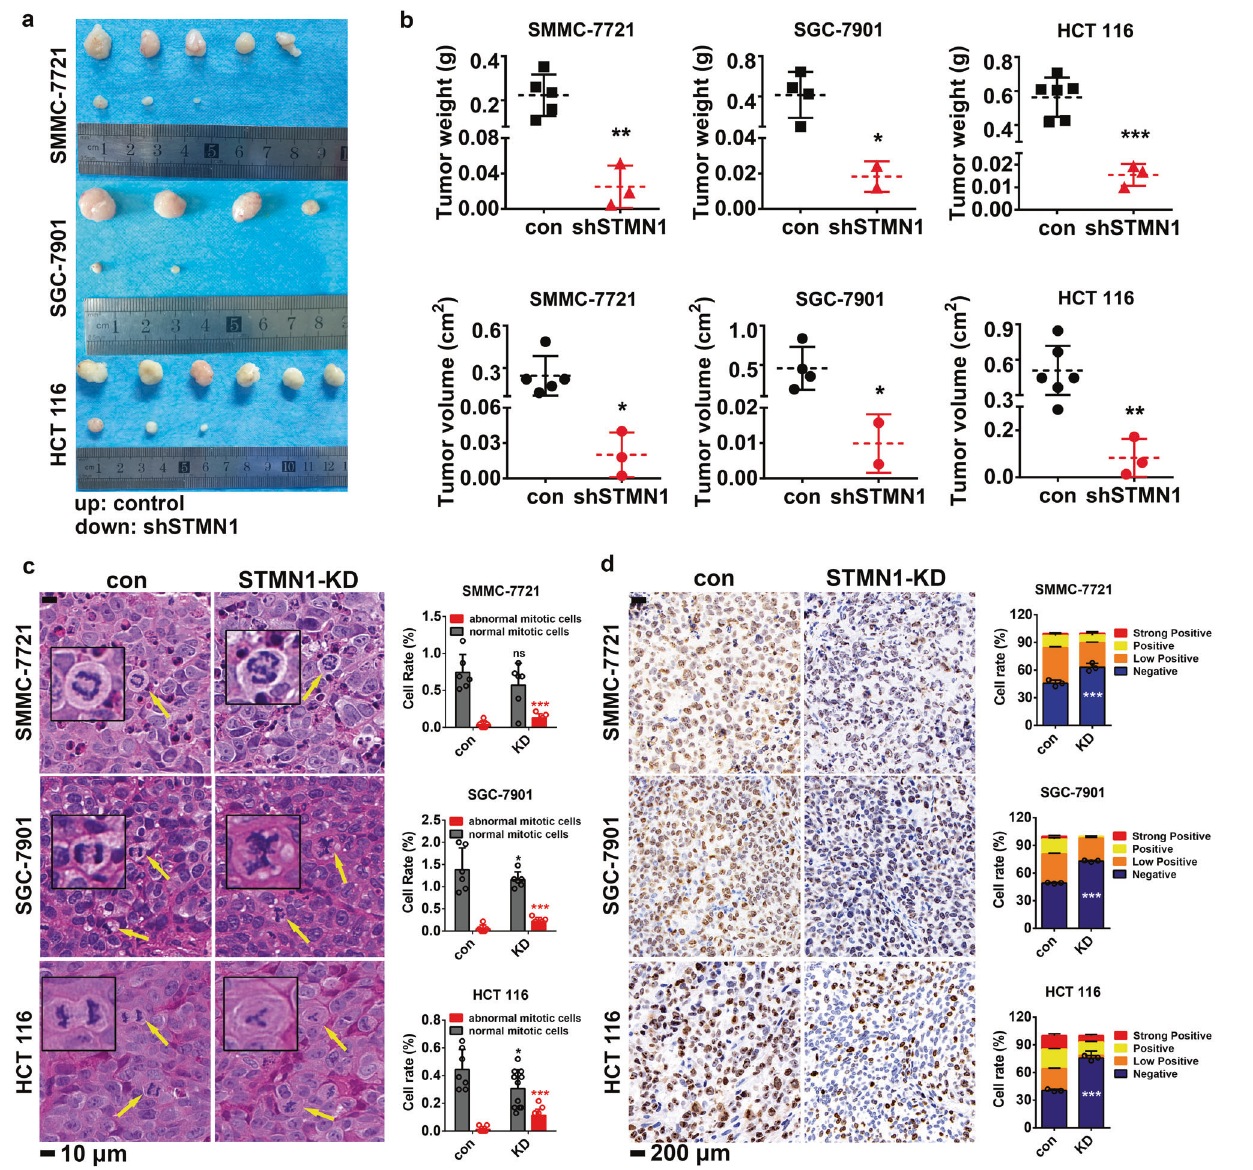
Fig. 4 STMN1 affects tumorigenesis in vivo. The hepatocellular carcinoma cell line SMMC-7721, gastric cancer cell line SGC-7901 and colorectal cancer cell line HTC 116 infected with shSTMN1 lentivirus and control lentivirus were injected subcutaneously into the back of 6- year-old nude mice for 4 – 6 weeks to grow tumors. The left side of the mice was injected with control cells and the right side was injected with shSTMN1-expressing cells. a The mice were killed after 4 – 6 weeks and tumors were removed to measure the weight. The tumor volume was measured and calculated by v = 0.5 × Length × Width 2 . SMMC-7721, n = 5. SGC-7901, n = 4. HCT 116, n = 6. The data were presented as the mean ± SD. The signi fi cance was analyzed by Student ’ s t -test. * P < 0.05, ** P < 0.01, *** P < 0.001. c HE staining was performed to observe the morphological changes of the nucleus. The yellow arrows show the typical normal or abnormal morphological changes of the nucleus in cell mitosis process. The scale bar is 10 μ m. The percentage of normal or abnormal cells was calculated by numbers of normal or abnormal nucleus divided by numbers of total nucleus × 100%. The data were presented as the mean ± SD of 6 – 11 different fi elds of view at low magni fi cation (20×). The signi fi cance was analyzed by Student ’ s t -test. * P < 0.05, *** P < 0.001. d Ki67 expression in the tumor was detected by IHC and the percentage of positive cells was calculated by ImageJ IHC Pro fi ler. The scale bar is 200 μ m. The data were presented as the mean ± SD of three different fi elds of view at low magni fi cation (50×). The signi fi cance was analyzed by Student ’ s t -test. *** P <